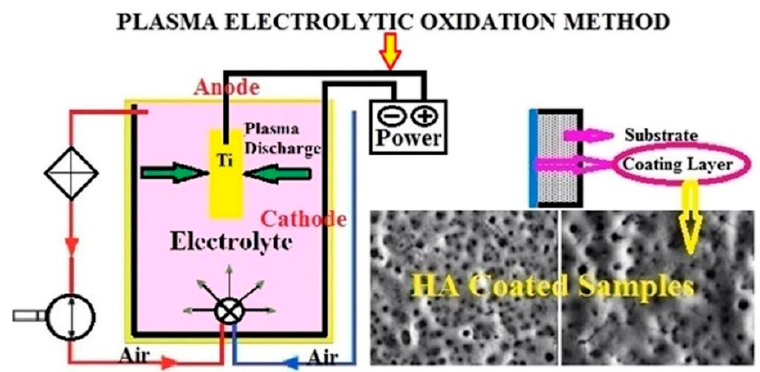
Figure 1. Morphology and schematic view of PEO method [15].